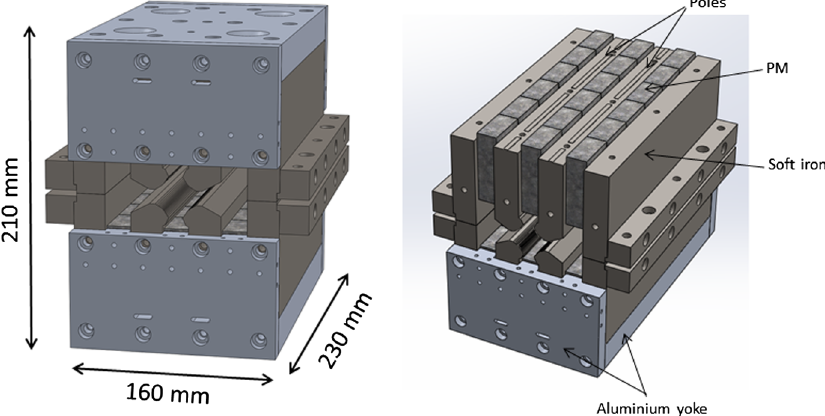
FIG. 9. Hybrid PM prototype CAD model. Dimensions of the prototype are indicated (left). The upper mechanical parts of the quadrupole are removed to show the PM arrangement in slots (right). The total mass of this prototype is 45 kg and the weight of PM material is 12 kg.